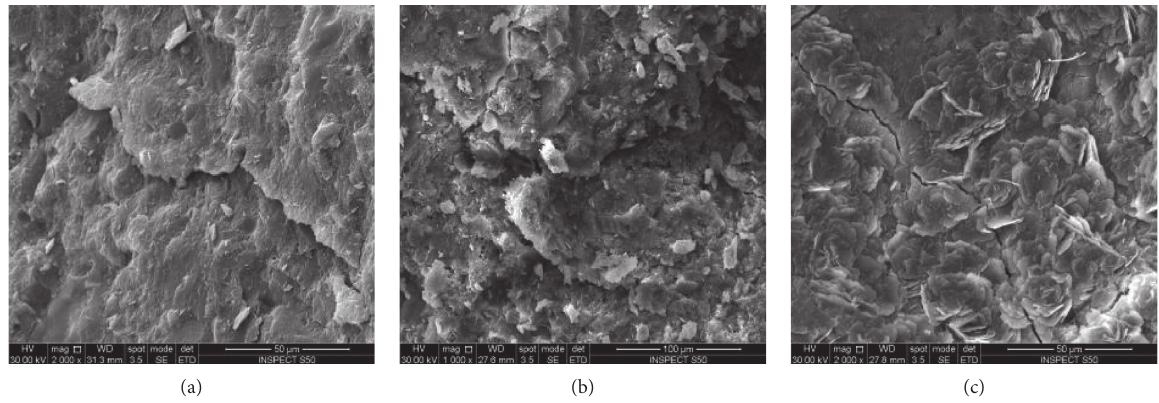
Figure 9: SEM maps of C3-7 after (a) 30, (b) 60, and (c) 90 freezing-thawing